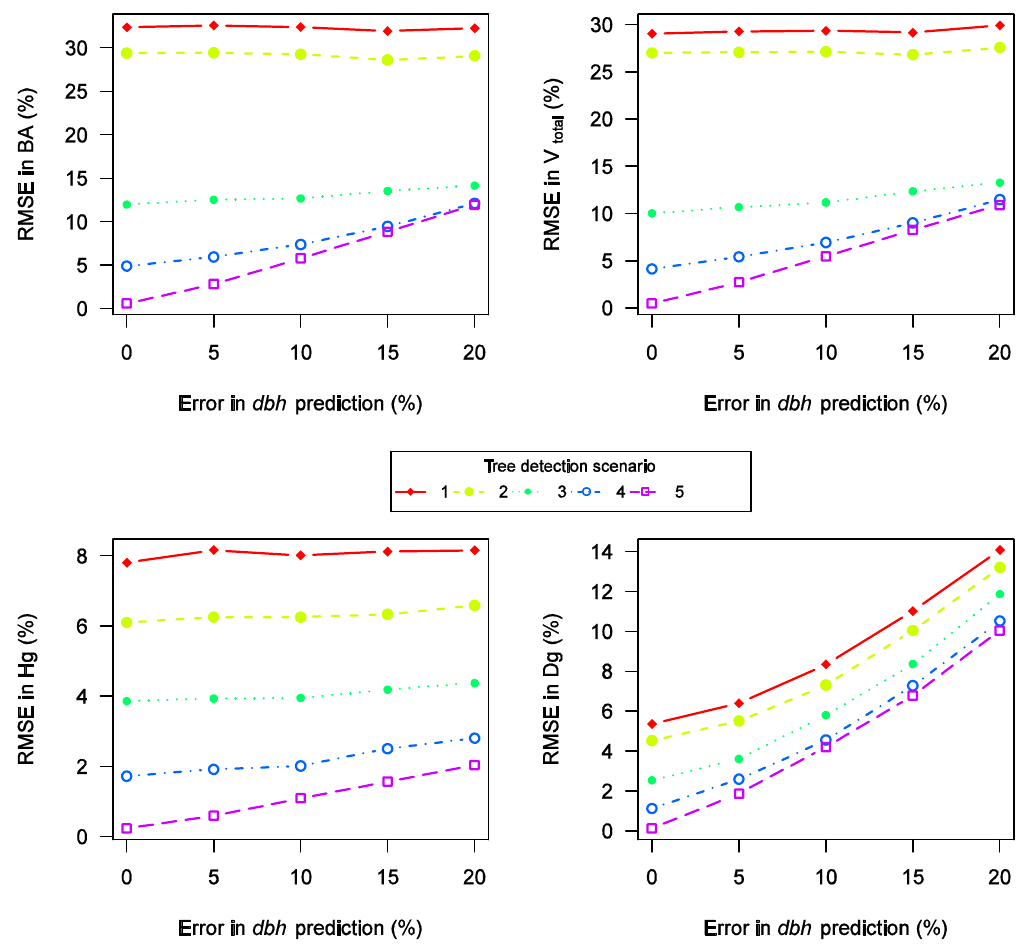
Figure 2. Combined effects of dbh prediction and tree detection on stand